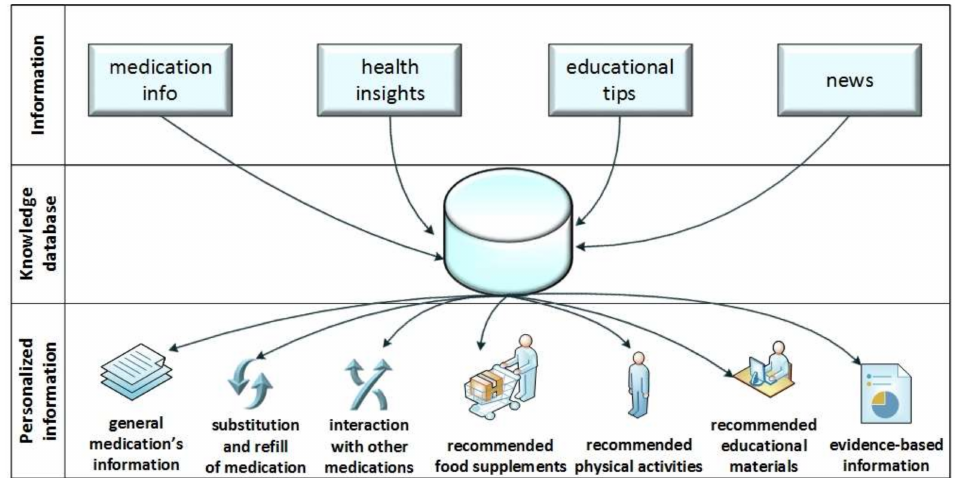
Figure 2. MyMediMan’s personalized features and